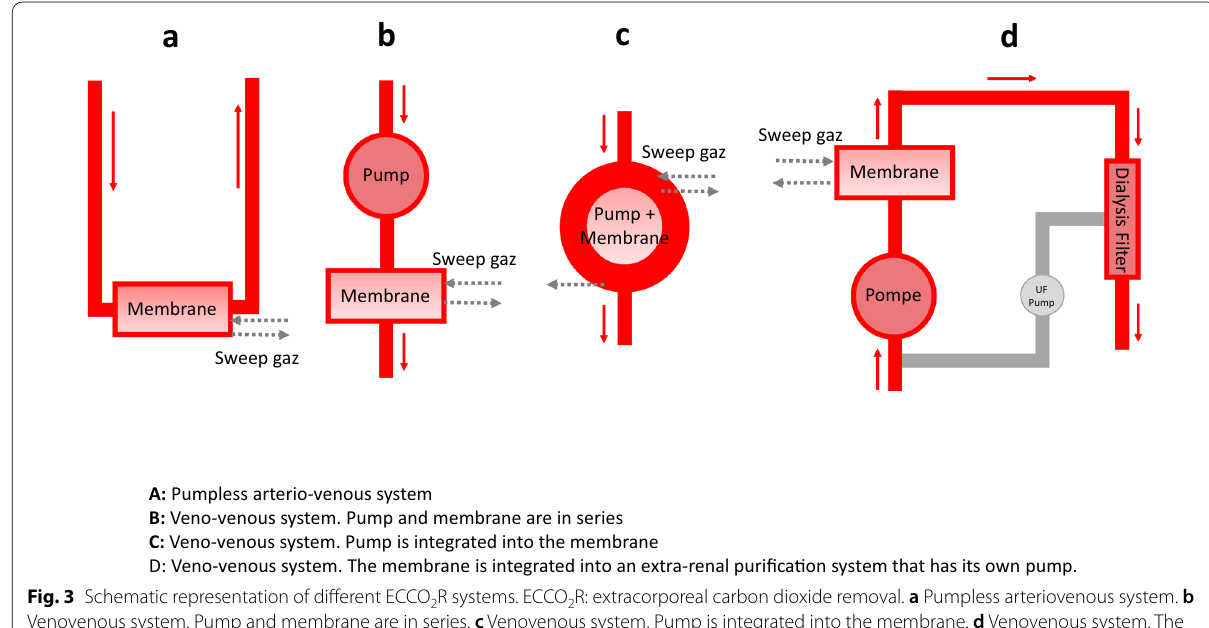
Fig. 3 Schematic representation of different ECCO 2 R systems. ECCO 2 R: extracorporeal carbon dioxide removal. a Pumpless arteriovenous system. b Venovenous system. Pump and membrane are in series. c Venovenous system. Pump is integrated into the membrane. d Venovenous system. The membrane is integrated into an extrarenal purification system that has its own pump